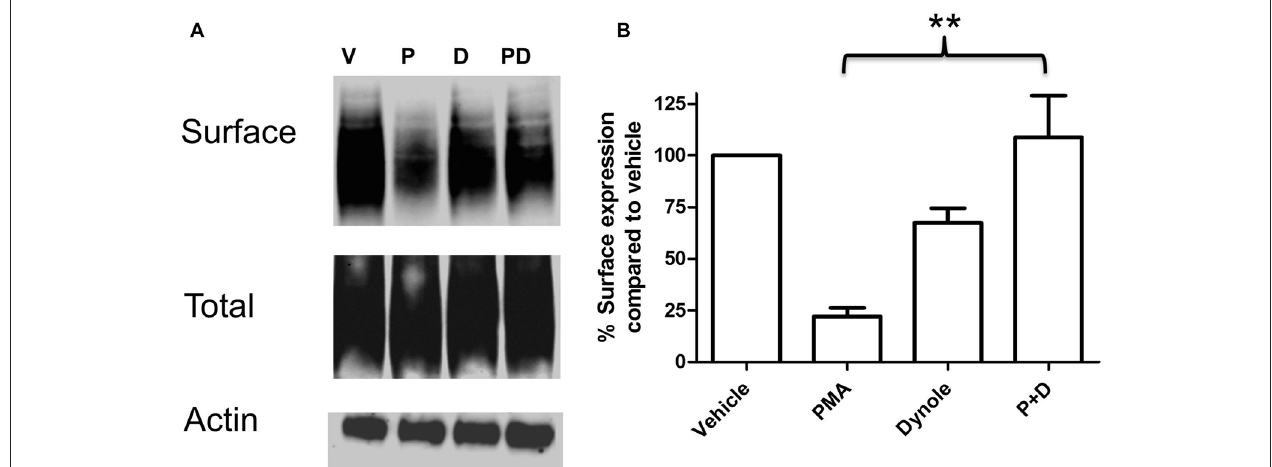
FIGURE 2 | PKC activation cause a dynamin dependent reduction in surface expression of NET. PC12 cells stably transfected with an HA-tagged NET were treated with PKC activator PMA and dynamin inhibitor Dynole 34-2. Cell surface biotinylation was performed and surface expressed NET was visualized through immunoblotting (A) . Band densities were quantified from three independent experiments (B) . Statistical significance was determined employing one-way ANOVA with Bonferroni post hoc analysis ( ∗∗ P < 0.01). P:PMA (1 µ M), D:Dynole 34-2 (20 µ M).